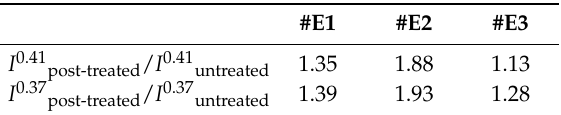
Table 1. Integrated intensities ratio of the untreated and the post-treated stratum corneum with ethanol for the lattice constants of 0.41 and 0.37 nm where the integrated intensities are denoted by I 0.41 untreated and I 0.37 untreated before treating with ethanol and by I 0.41 post-treated and I 0.37 post-treated after removing ethanol. The data are given for three samples, #E1, #E2, and